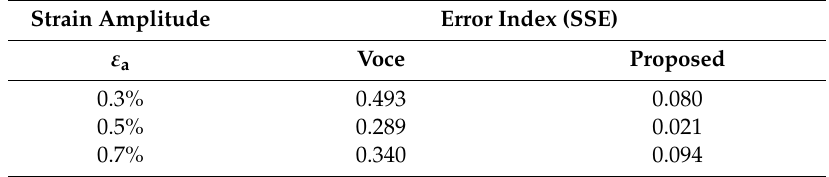
Table 2. Evaluation of fitted curves obtained with both models and calculated with b all , a all and s all .